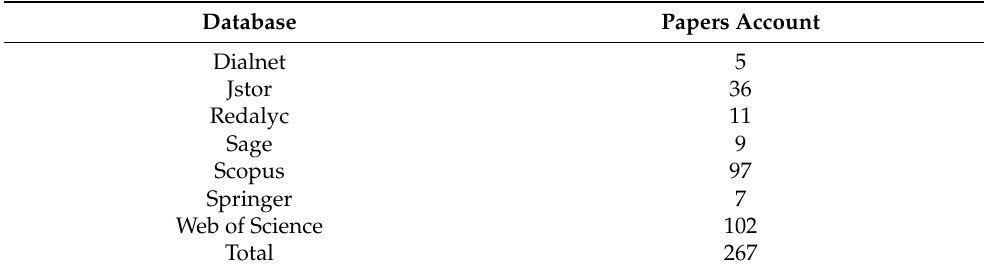
Table 1. Specialized databases for data